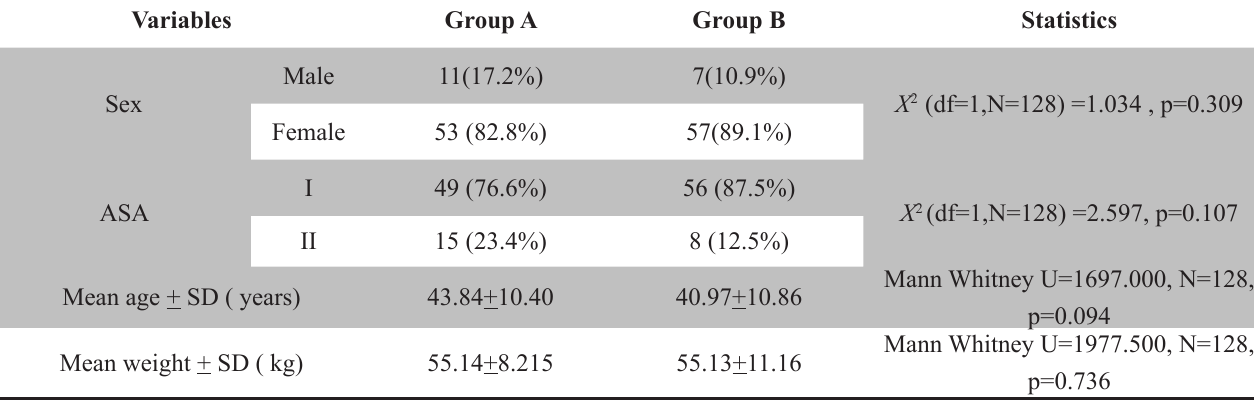
Table 1. Comparison of demographic variables between the two groups.